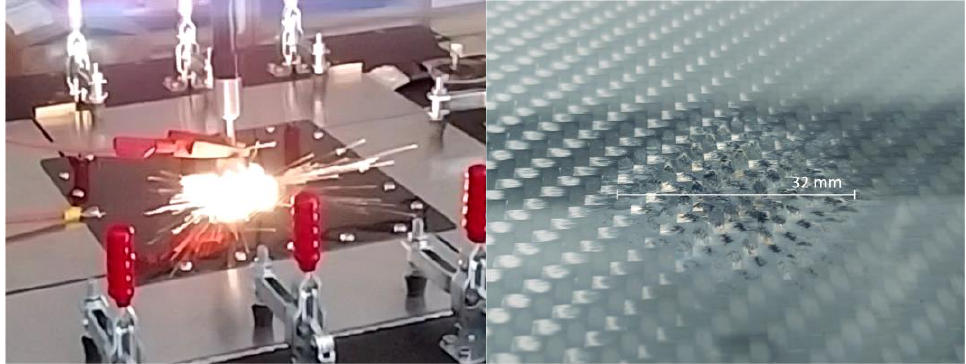
Figure 12. View of the composite sample during the test (on the left) and its visible damage (on the right). (on the right